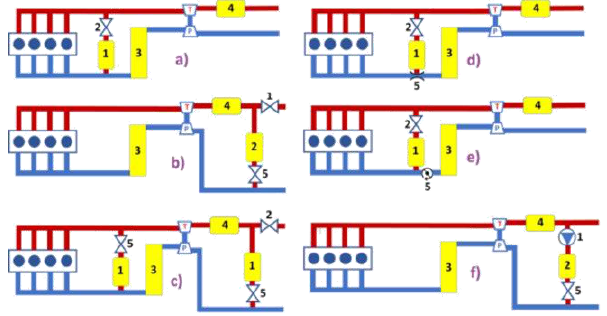
Fig. 2. Example EGR-Systems for CI engines [16]. a) Short-Route-system (SR), 1 – EGR-cooler, 2 – EGR-valve, 3 – Charge Air Cooler (CAC), 4 – Diesel Particulate Filter (DPF); b) Long-Route-system (LR), 1 – Exhaust throttle, 2 – EGR-cooler, 3 – CAC, 4 – DPF, 5 – EGR-valve; c) Hybrid system, 1 – EGR-cooler, 2 – Exhaust throttle, 3 – CAC, 4 – DPF, 5 – EGR-Valve; d) Venturi system, 1 – EGR-cooler, 2 – EGR-valve, 3 – CAC, 4 – DPF, 5 – Venturi; e) Fast rotating valve system, 1 – EGR-cooler, 2 – EGR-valve, 3 – CAC, 4 – DPF, 5 – Fast rotating valve; f) Pump